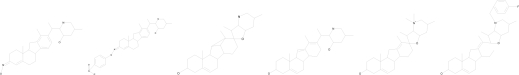
Six molecules that did not match any of the scaffolds, as mentioned above.